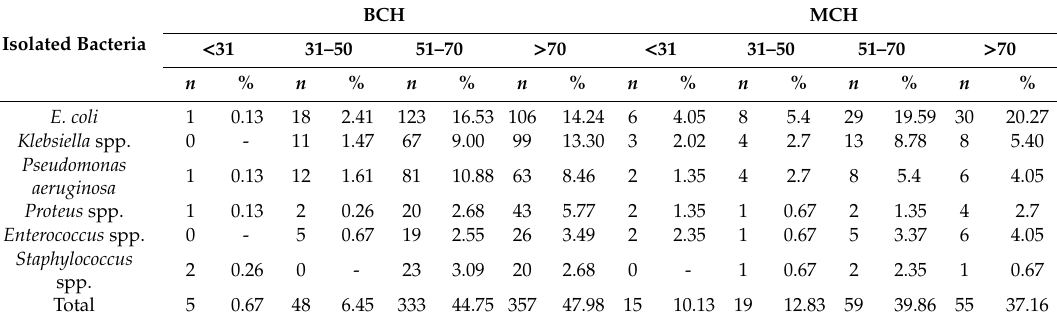
Table 2. Uropathogens in male patients of various age groups in Burghele Clinical Hospital (BCH) and Mures County Hospital (MCH).